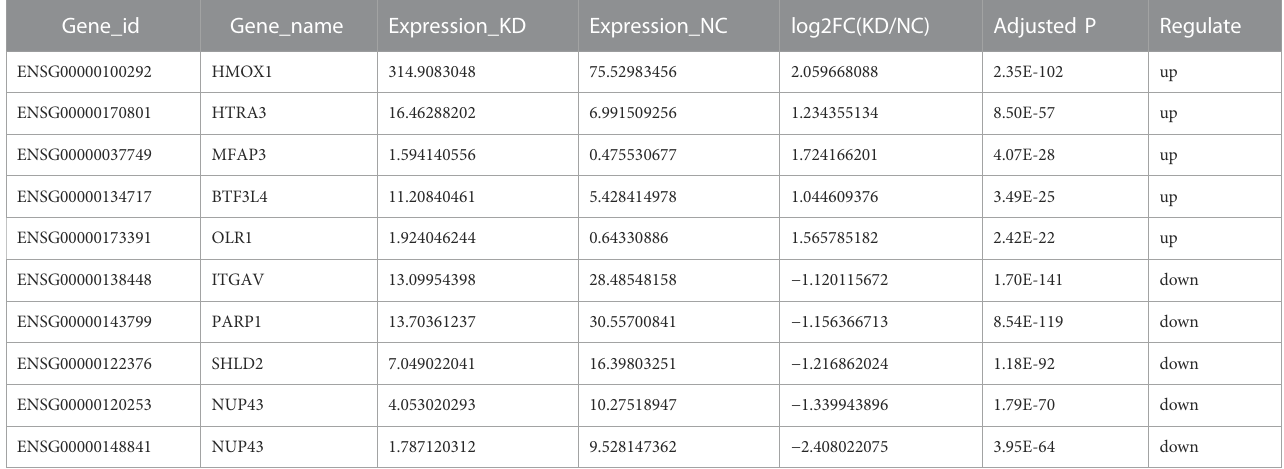
TABLE 1 List of top 5 up-regulated and down-regulated DEGs of